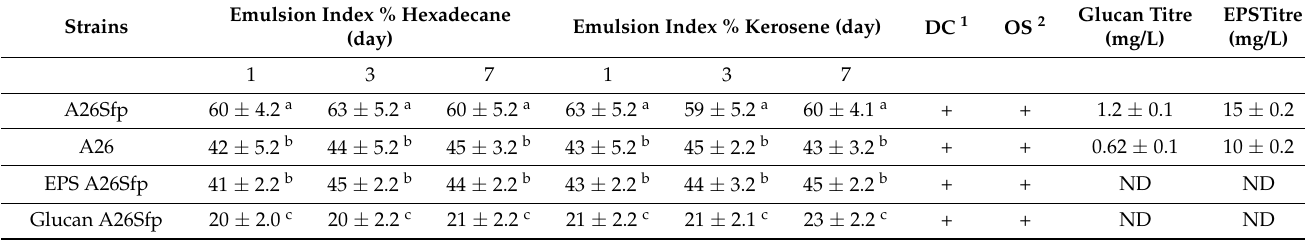
Table 2. Emulsion indices (%) of the strains using kerosene and hexadecane, glucan titre and other characteristics. Emulsion Index % Hexadecane Strains Emulsion Index % Kerosene (day)